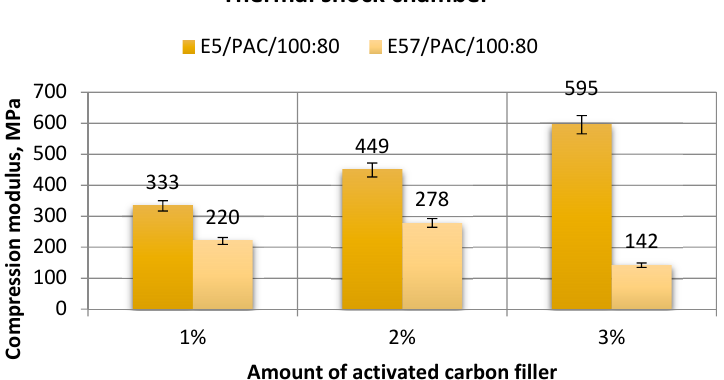
Figure 23. Comparison of the compression modulus between the E5/PAC/100:80 and E57/PAC/100:80 epoxy specimens modified by the activated carbon filler post ‐ thermal shock chamber aging.